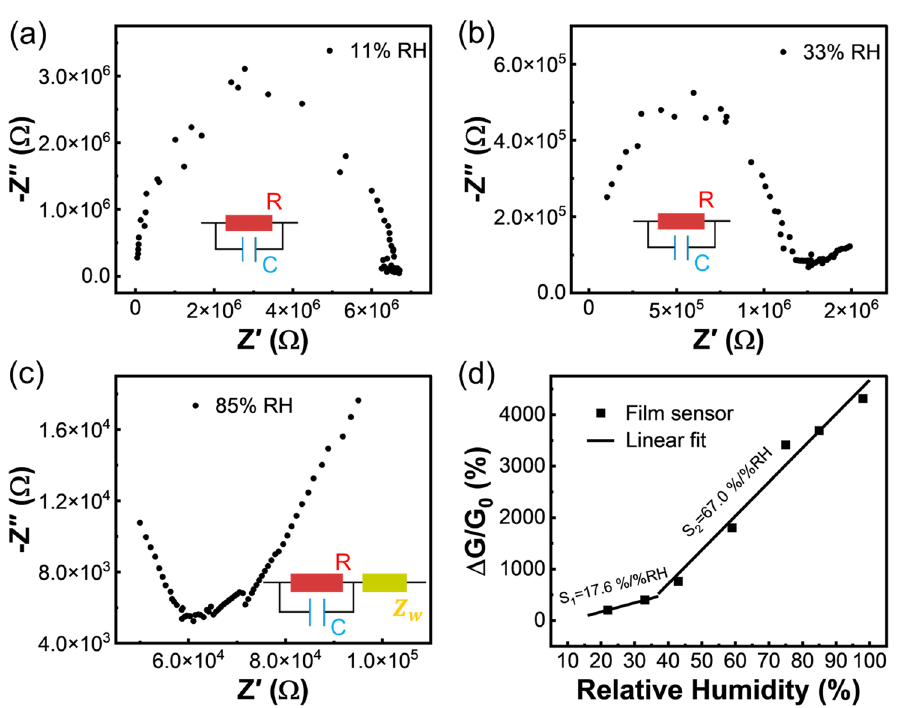
Fig. 3 a-c The complex impedance spectra of the humidity sensor under 11, 33, and 85% RH environment. d Piecewise fitting of response ver- sus RH within 11–98%